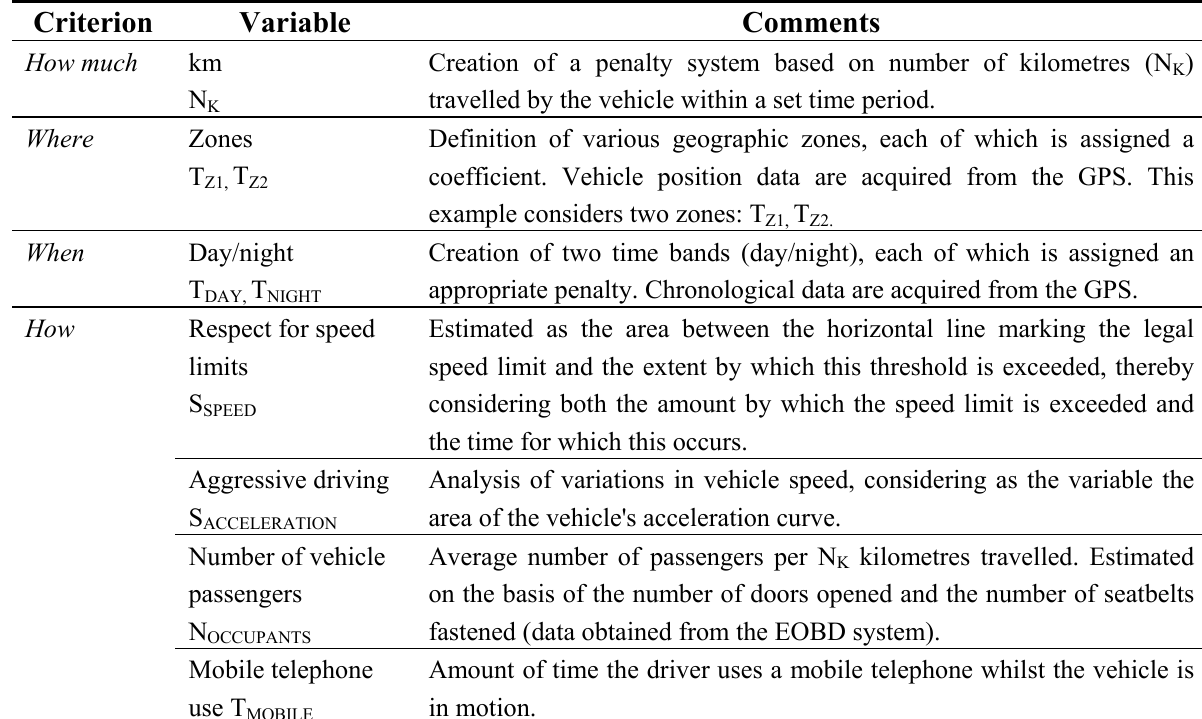
Table 2. Possible data analysis